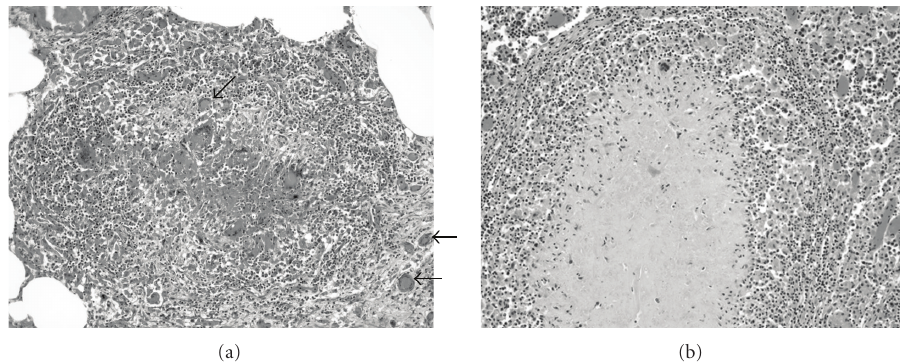
Figure 1: Histology of lung (a) and pulmonary lymph node (b) lesions. Typical tuberculoid granulomas demonstrating central necrosis (particularly apparent in the lymph node lesion) surrounded by epithelioid macrophages and multinucleated, Langhans-type giant cells (examples noted with arrows) admixed with